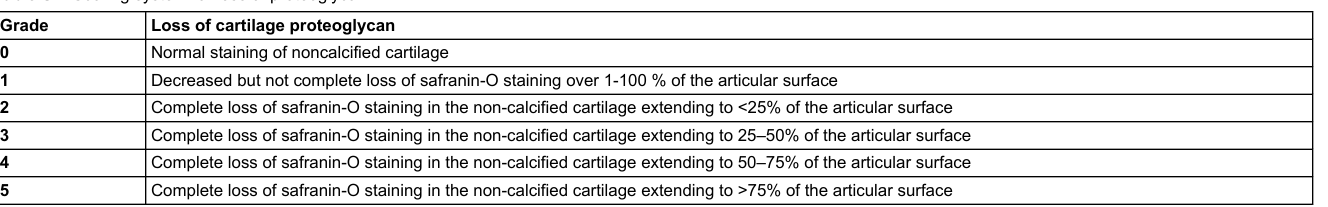
Table S2: Scoring system for loss of